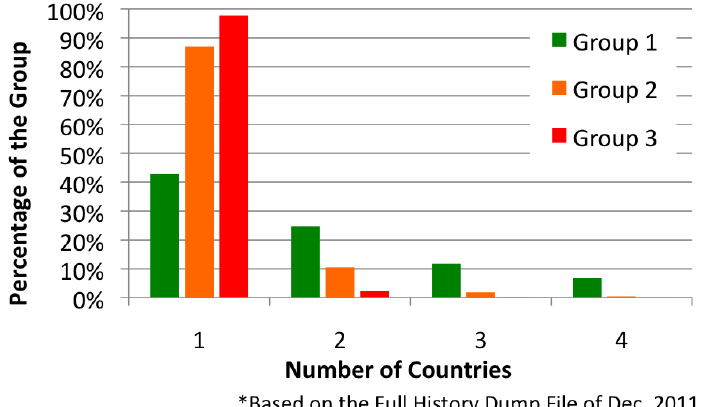
Figure 11. Number of countries per OSM contributor